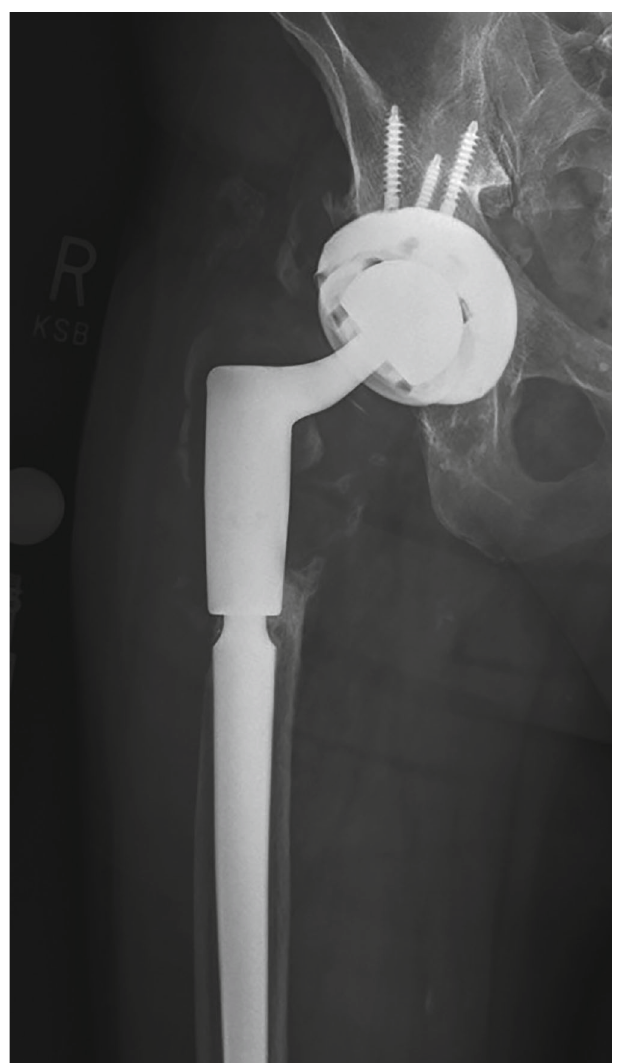
Figure 1: Preoperative anteroposterior X-ray of the right